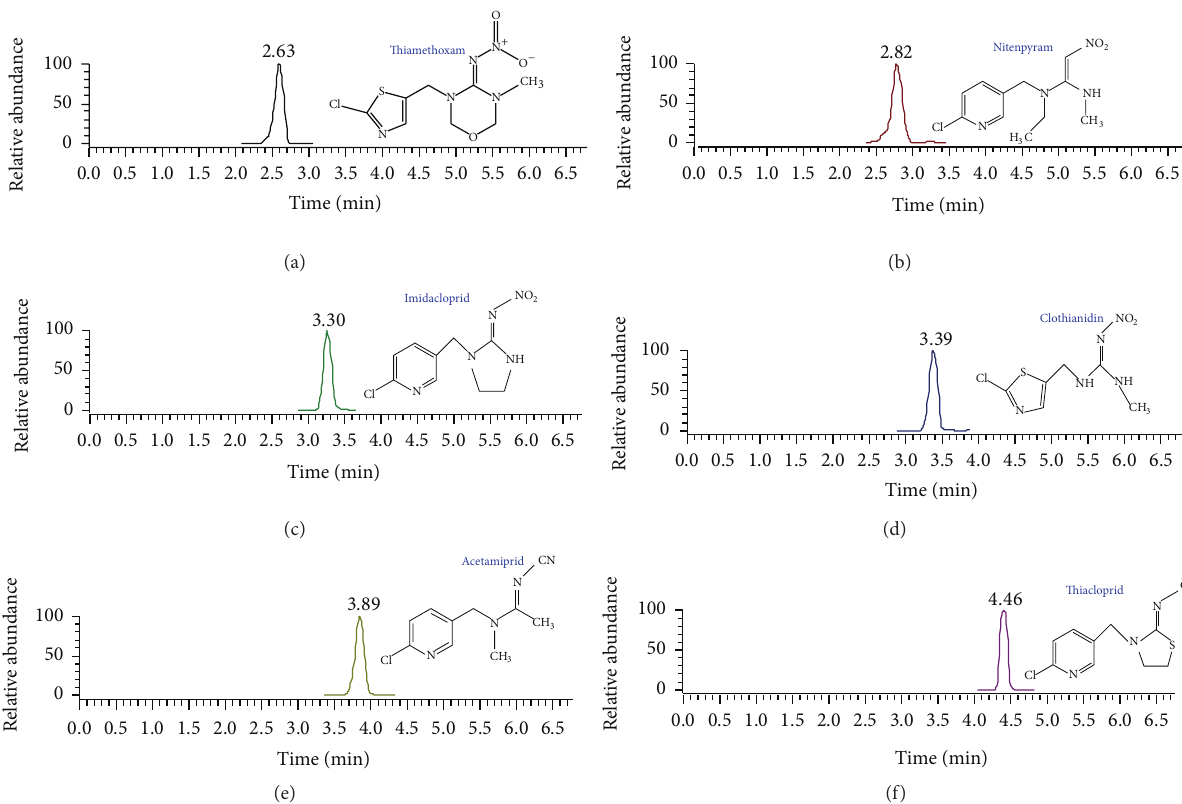
example, the manufacturer gives a volume of 10.00 ± 0.02 mL